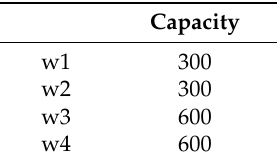
Table A20. Capacity of wind plants (MW): w_capacity( w ).